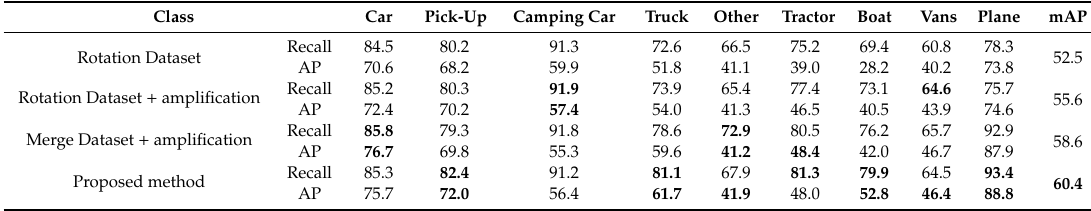
Table 8. The mean of ablation experimental results of HBB from two